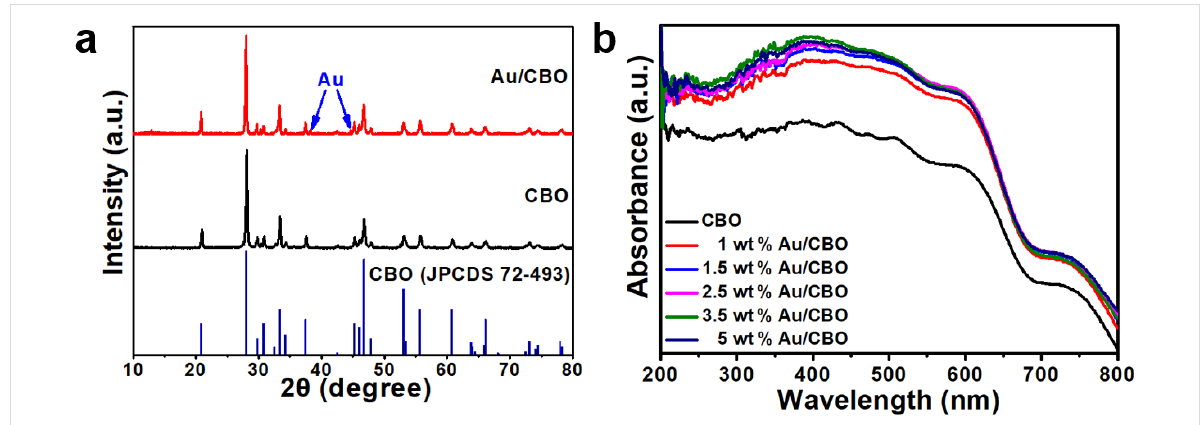
Figure 2: (a) XRD patterns of CBO and 2.5 wt % Au/CBO; (b) UV–vis diffuse reflectance spectra of as-prepared composites.